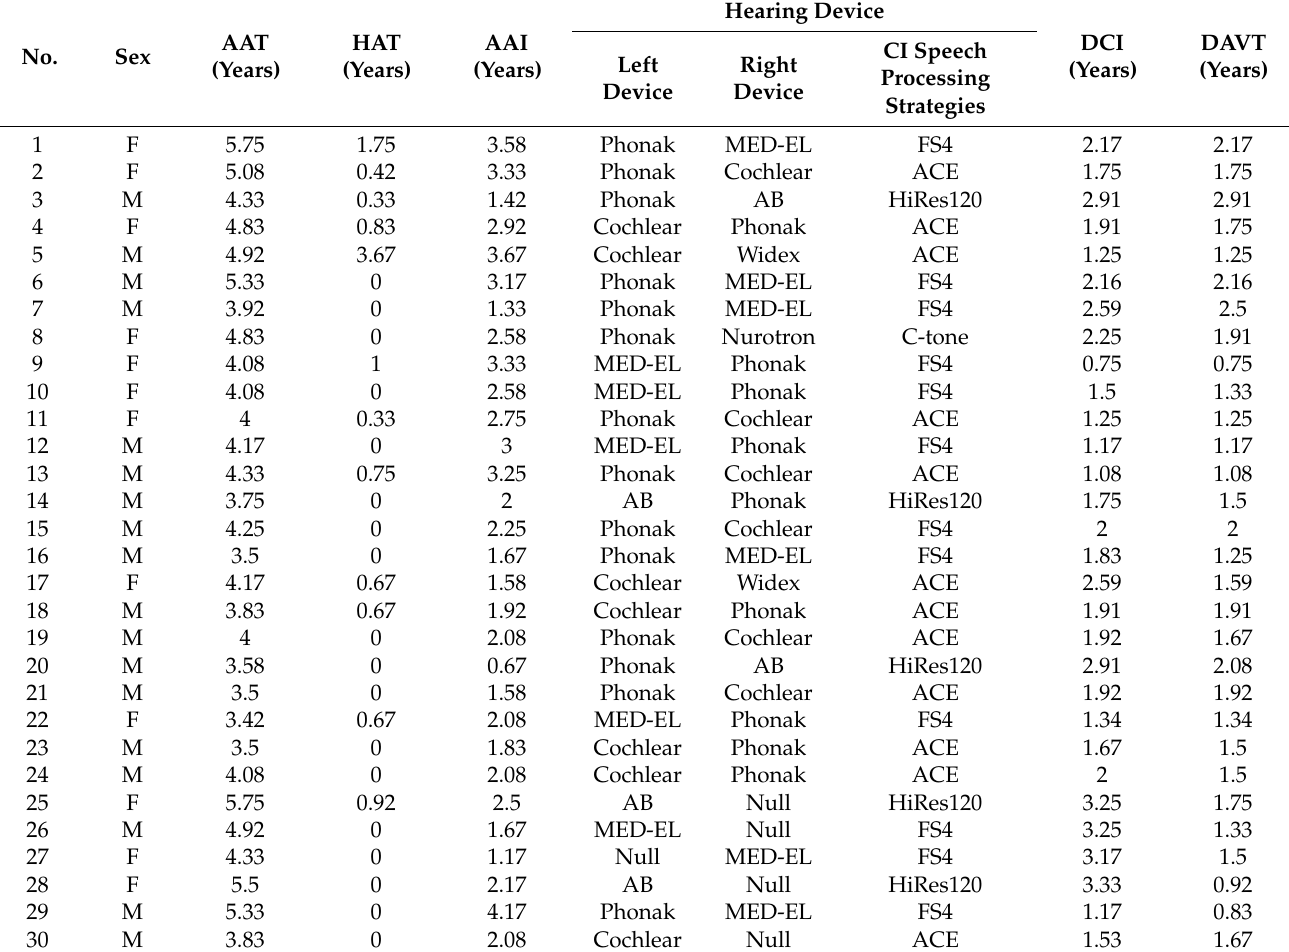
Table 1. Demographics of children with